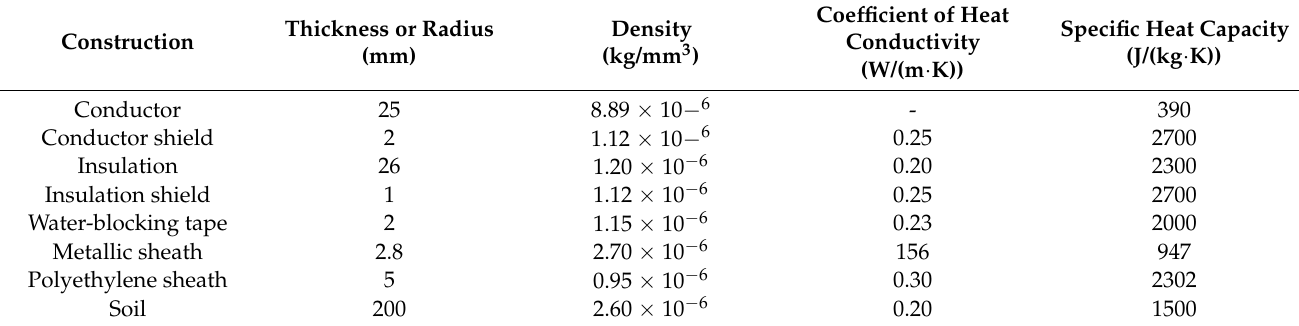
Table 1. Size and the material parameter of the 320 kV HVDC cable.